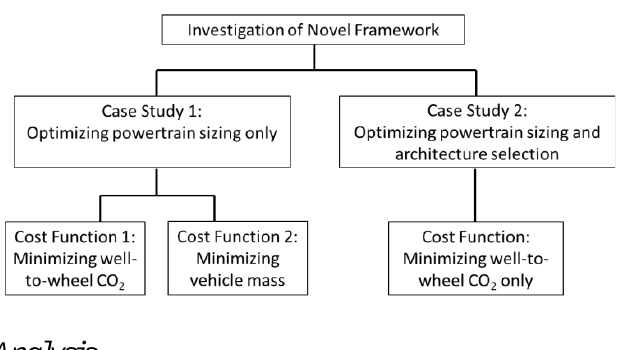
Figure 9. Investigation methodology for testing the